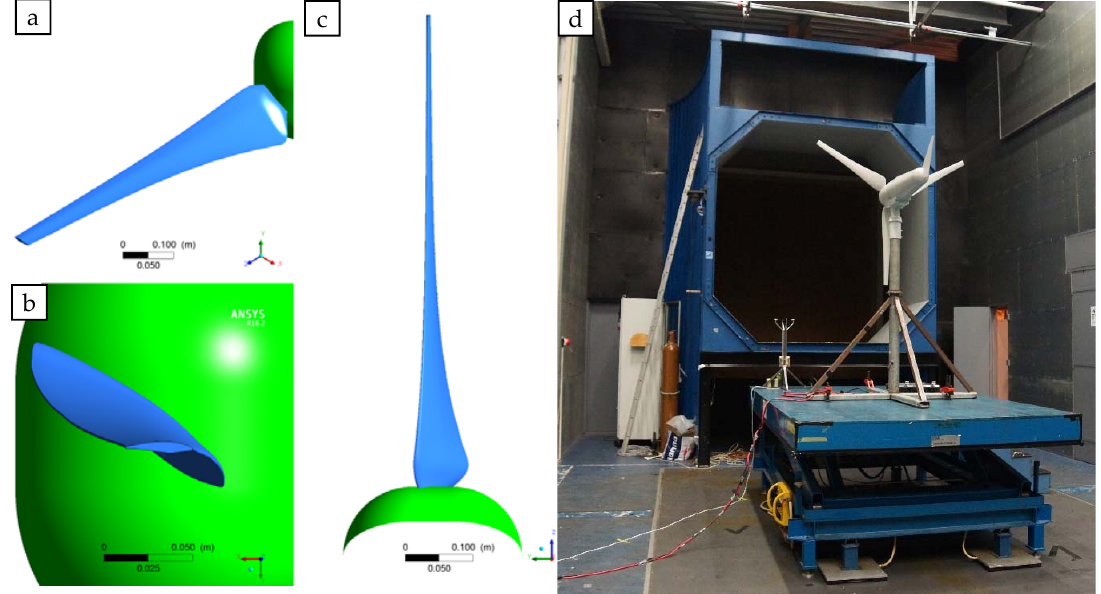
Figure 1. Blade geometry (left): ( a ) general view; ( b ) top view; ( c ) leading edge and suction side; and ( d ) wind turbine prototype during wind tunnel testing (own materials).